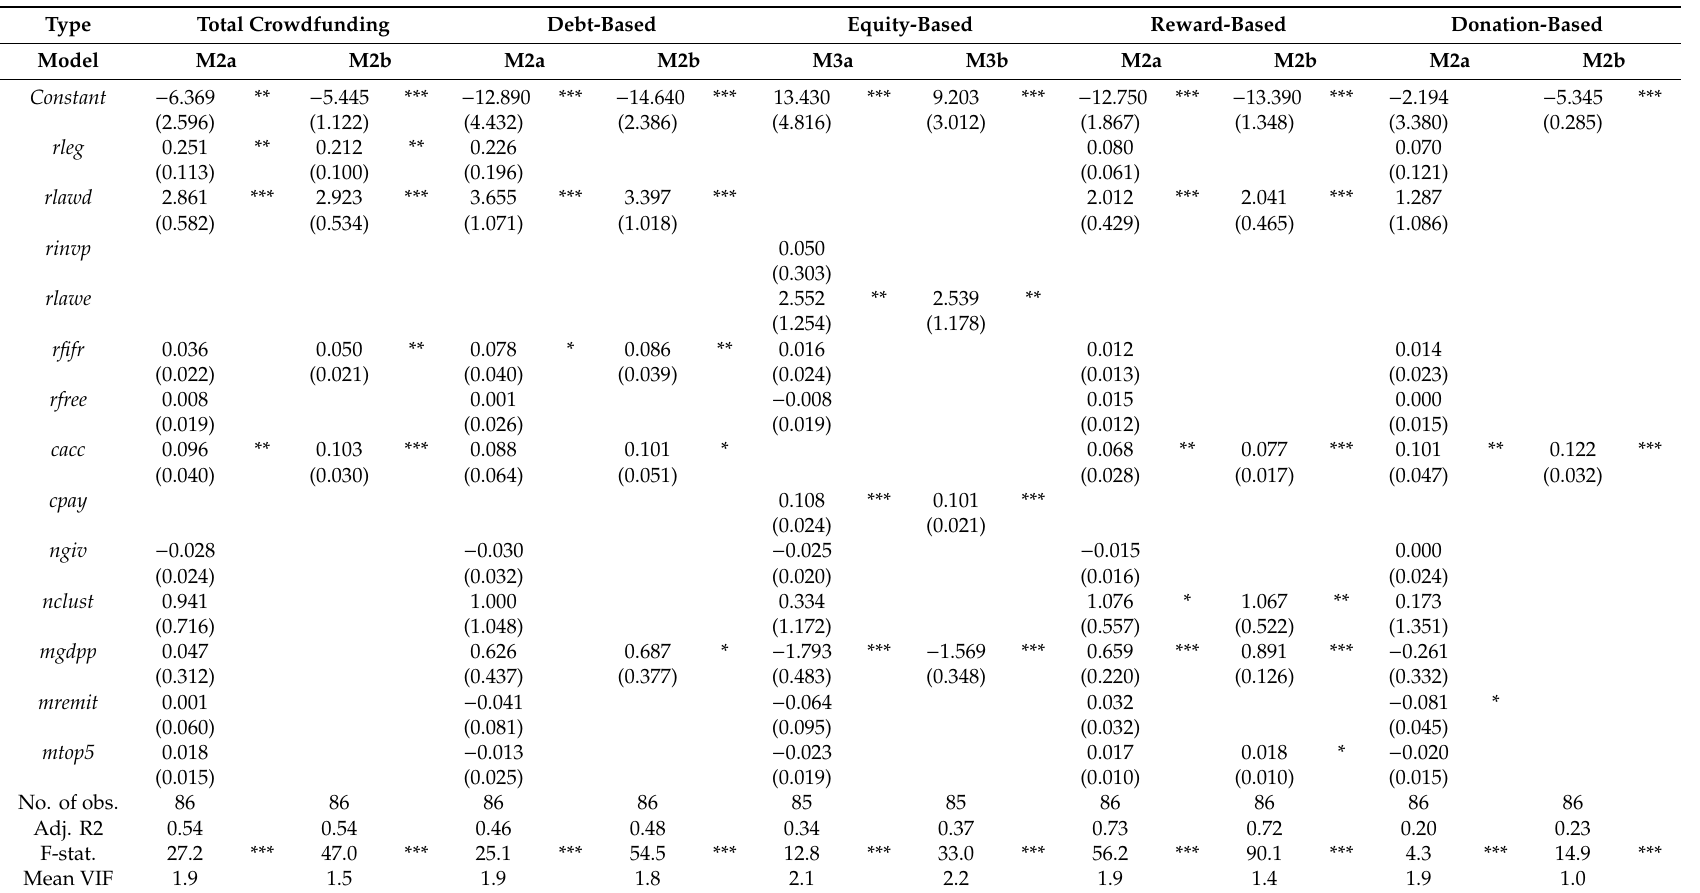
Table A3. Institutional Determinants of Crowdfunding Volumes during 2013–2016 per Capita by Types of Crowdfunding.